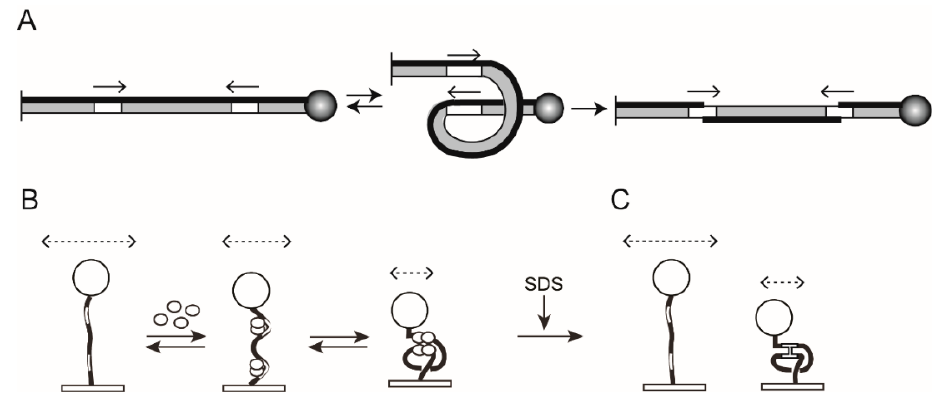
Figure 5. TPM analysis of tyrosine recombination between head-to-head sites. The panels ( A – C ) are arranged as in Figure 4. Note that the outcome of the recombination is DNA inversion between the target sites, indicated by the switch in the thickness of the two strands within the inverted segment. The configuration of the looped DNA in synapsed molecules is different for head-to-head and head-to-tail sites in order to accommodate the anti-parallel arrangement of sites. Note that, following SDS addition ( C ), only the Holliday junction intermediate will remain in the low BM amplitude state. Unreacted molecules, as well as molecules that underwent recombination, will be indistinguishable from each other by their BM amplitudes.